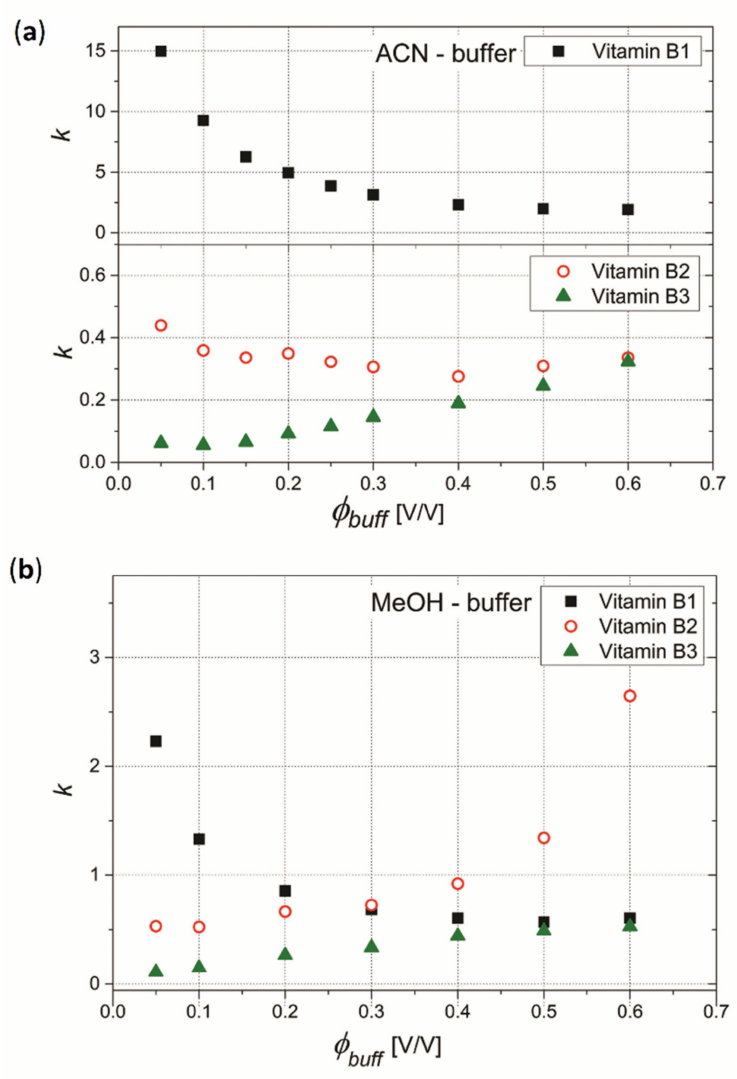
Figure 3. Effects of mobile phase composition ϕ buff on retention coefficient k of vitamins obtained using column N (Nucleodur C18 Gravity–SB) with: ( a ) acetonitrile and ( b ) methanol as mobile phase